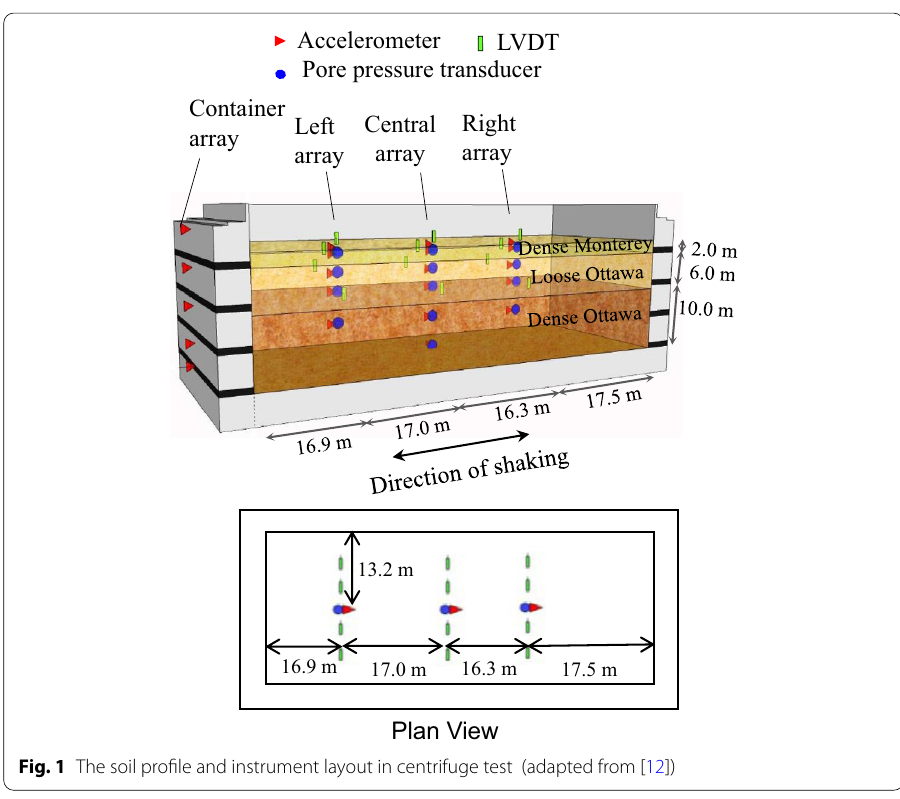
Fig. 1 The soil profile and instrument layout in centrifuge test (adapted from [12])